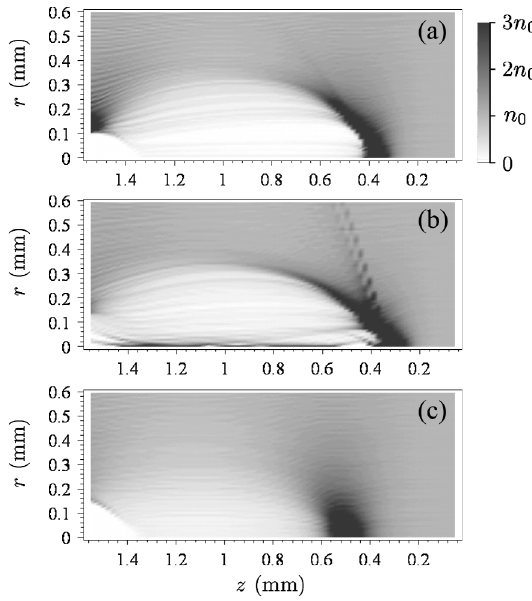
FIG. 11. Maps of the plasma electron density for optimum (a), low (b), and high (c) driver emittances at L ¼ 60 m